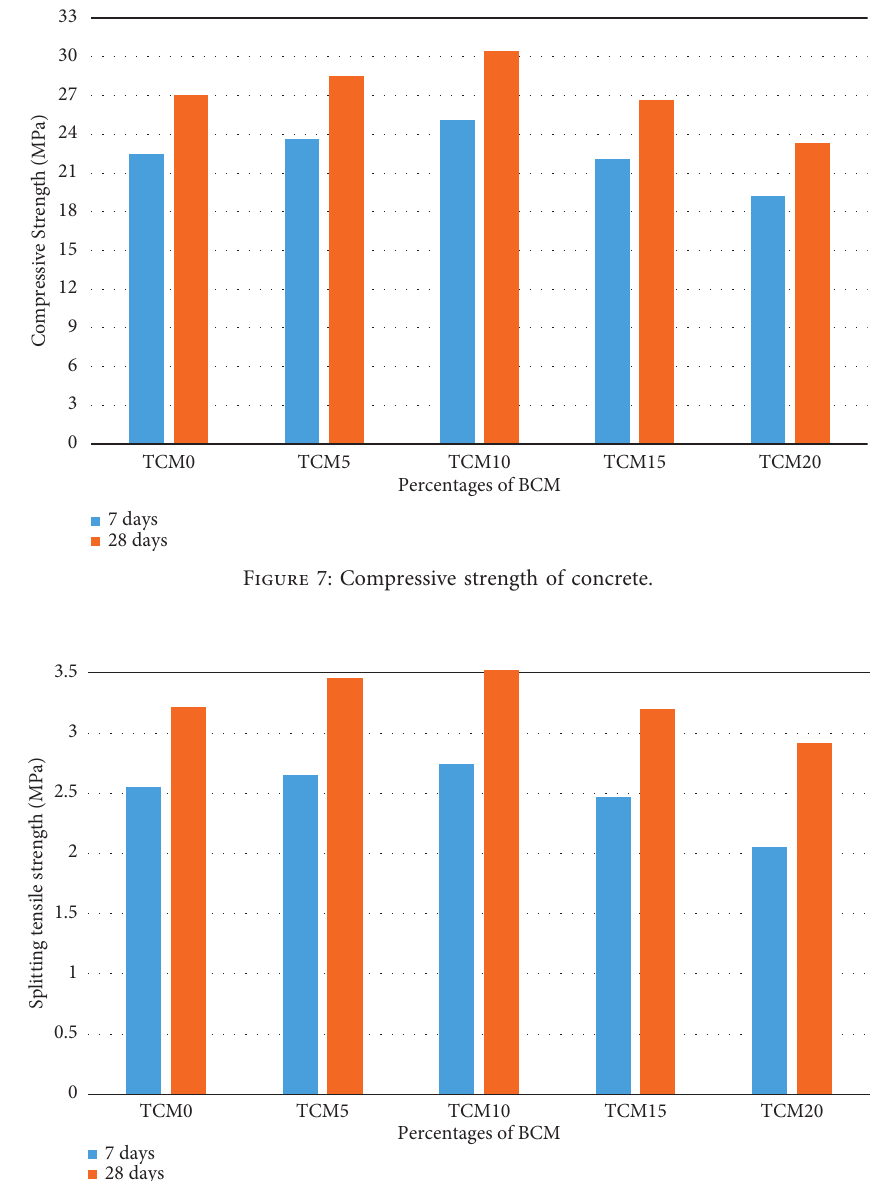
Figure 8: Splitting tensile strength of